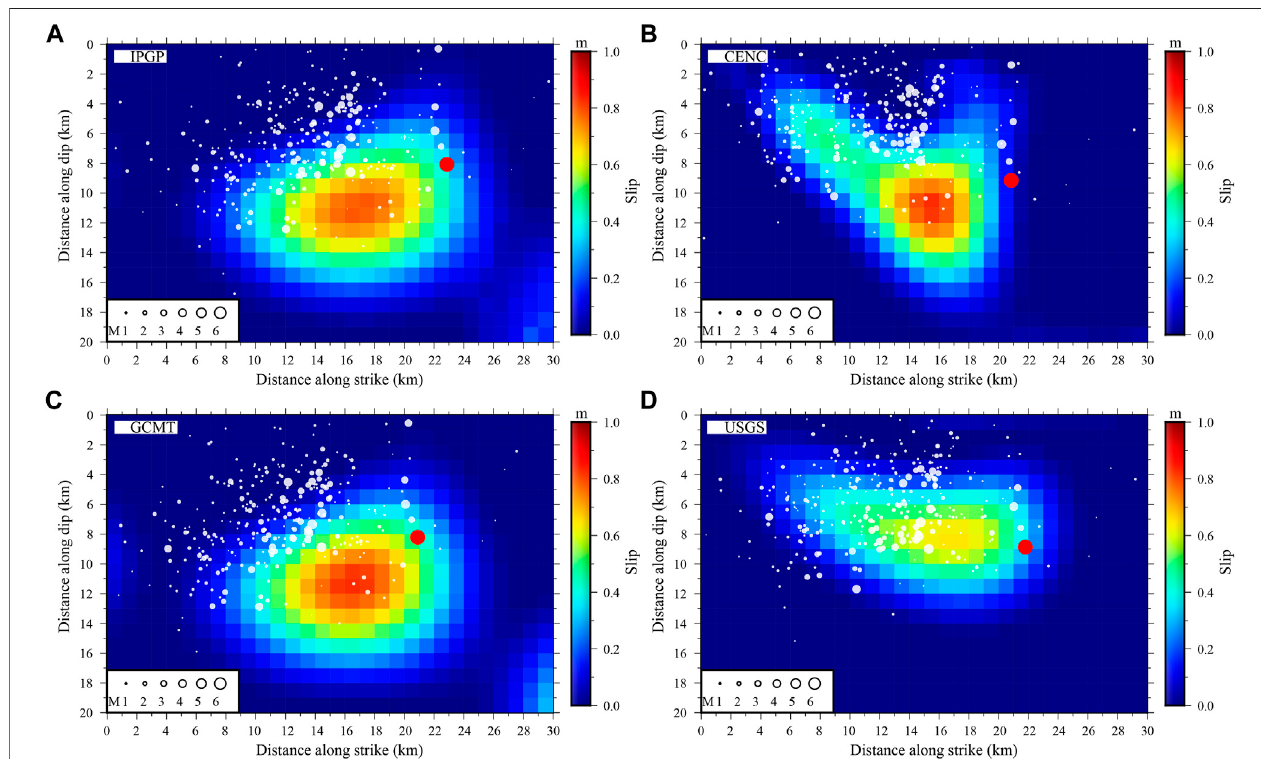
FIGURE 8 | Projections of aftershocks parallel to the fault slip planes with EW trending. The red dot indicates the mainshock. The white dots indicate the aftershocks. Red to blue shading indicates the amount of slip from large to small on the fault slip plane. Slip distribution are constrained by focal mechanism solutions from (A) IPGP, (B) CENC, (C) GCMT, and (D)